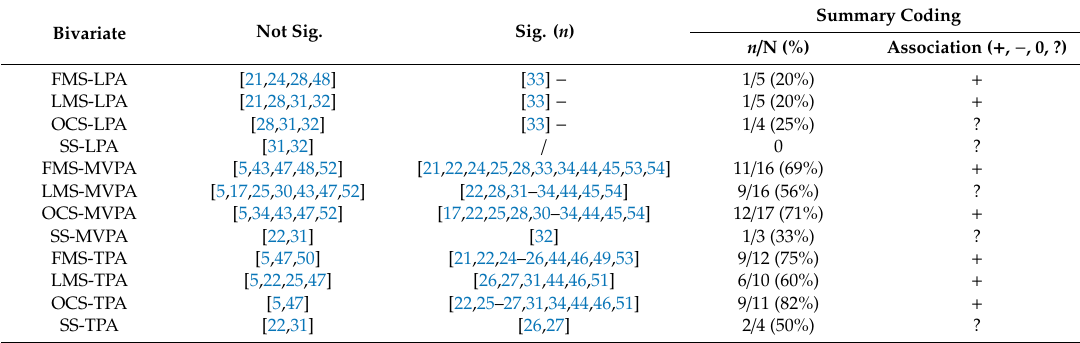
Table 5. Overall level of evidence for associations between FMS types and specific-intensity PA. Bivariate Not Sig. Sig. ( n )